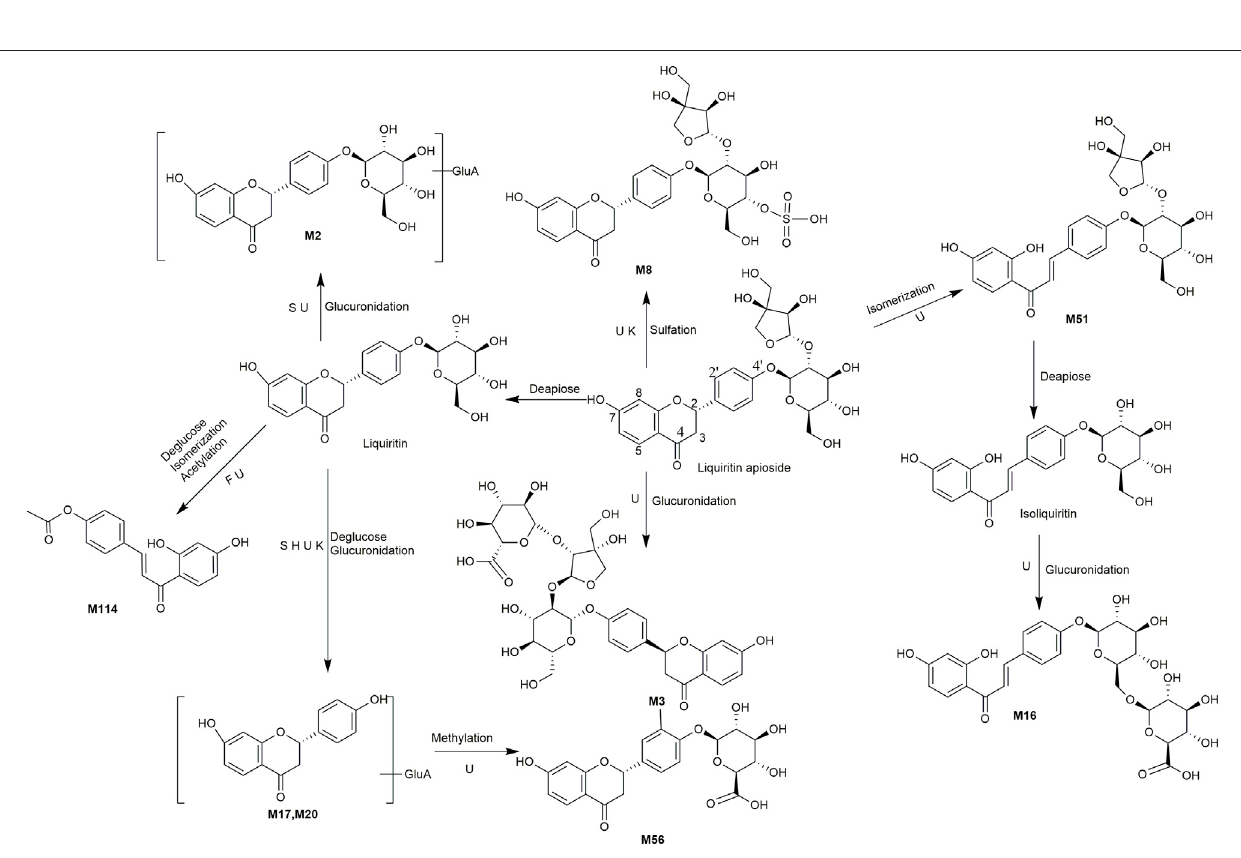
Frontiers in Chemistry |